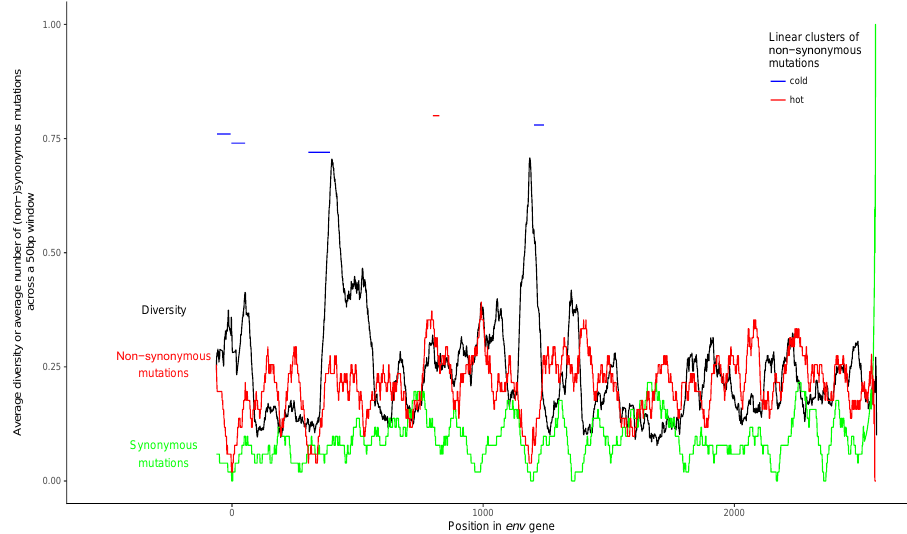
Supplementary Figure 2. Correlation between the presence of nonsynonymous and synonymous mutations with diversity across the env gene. Linear clusters were computed with MACML (Zhang, Townsend